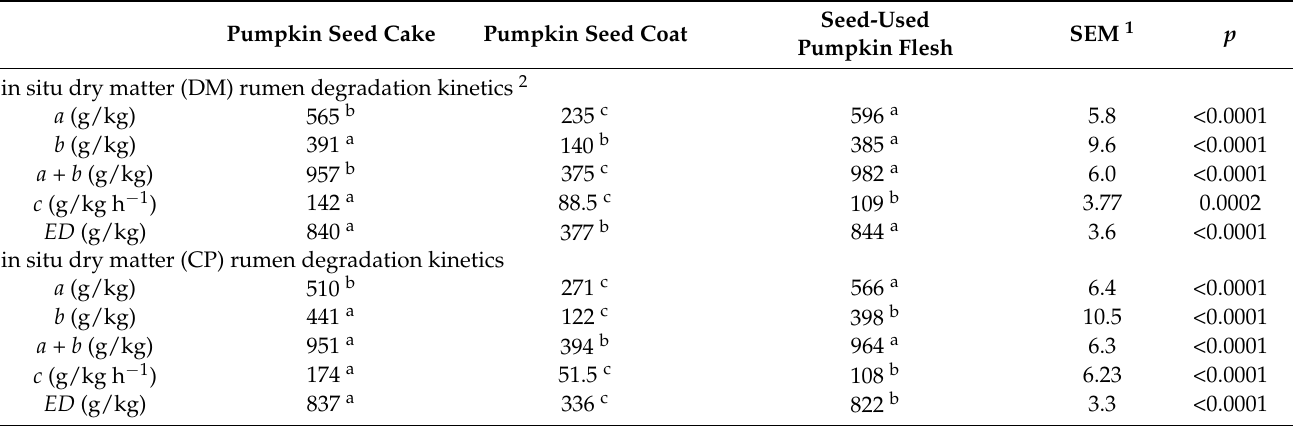
Table 2. In situ rumen degradation kinetics in different byproducts of seed-used pumpkin. Pumpkin Seed